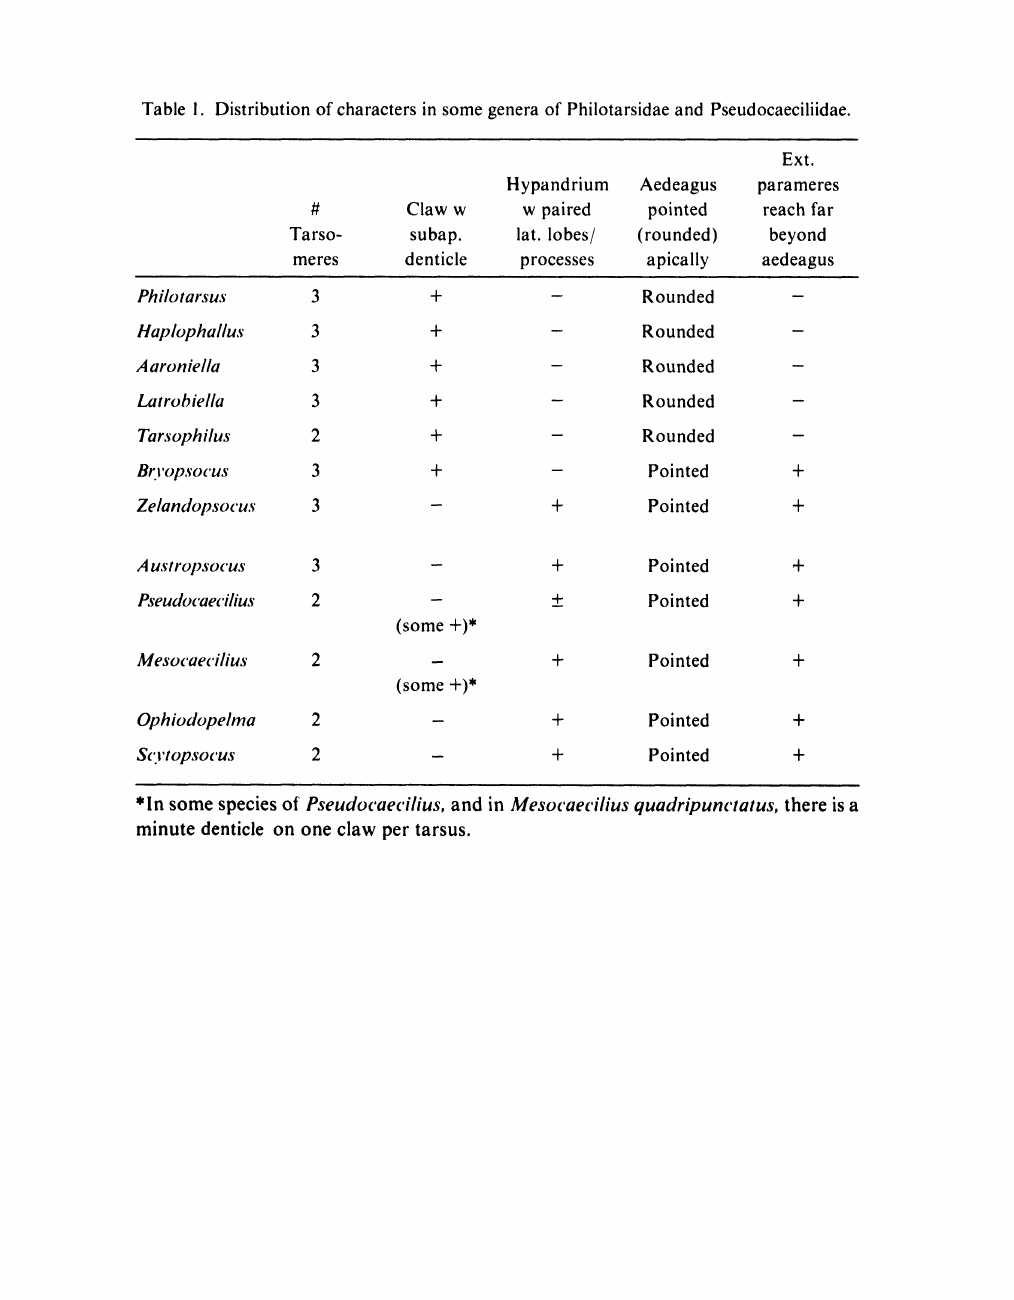
Table I. Distribution of characters in some genera of Philotarsidae and Pseudocaeciliidae.